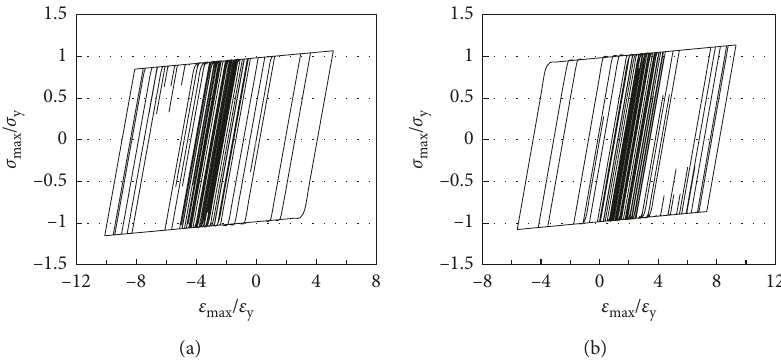
Figure 8: Hysteretic curves of BRBs on the third floor: (a) BRB on the left; (b) BRB on the